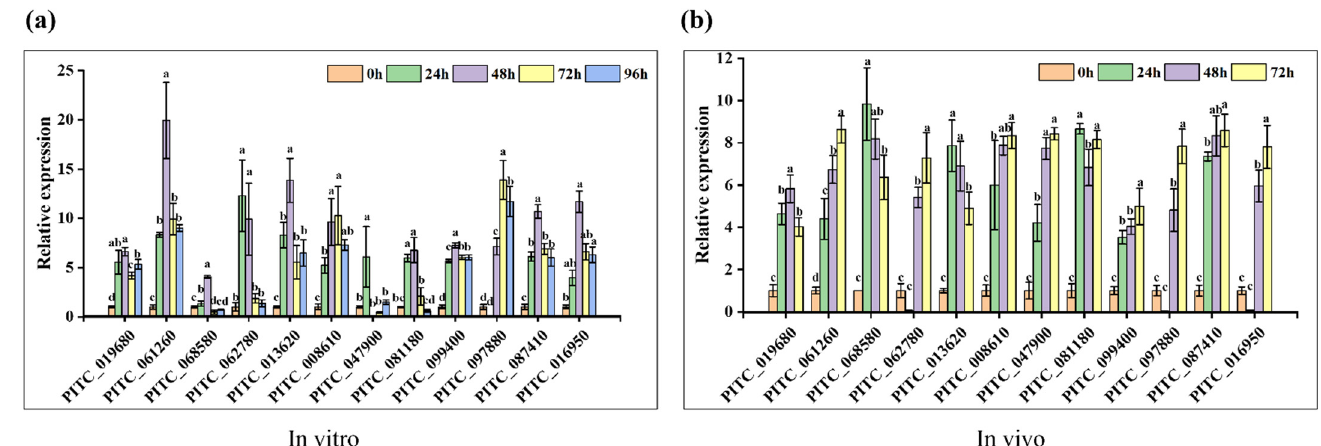
Figure 3. Expression patterns of 12 candidate effector genes are determined by RT-qPCR when cultivated on PDA (in vitro) ( a ) and during infection and development of P. italicum on Navel oranges (in vivo) ( b ). β -actin gene of P. italicum serves as an endogenous control. Samples collected at 0 h post-inoculation (hpi) are used to calibrate expression levels. Different letters indicated significant difference. Bars indicated standard error.